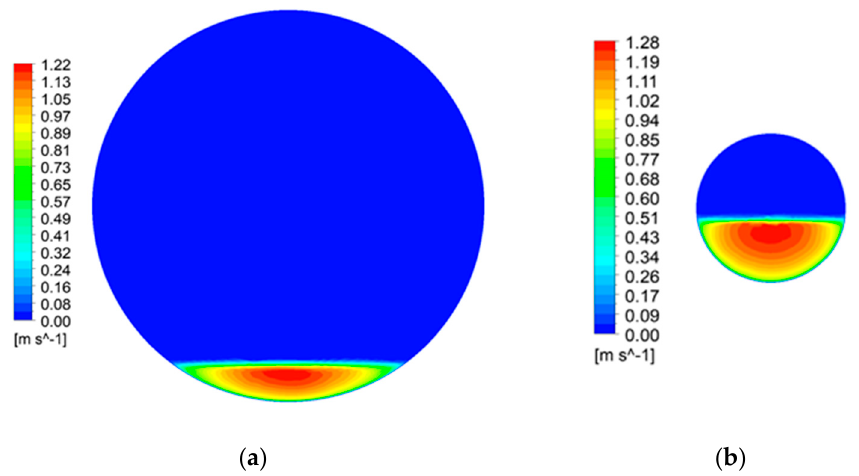
Figure 9. Velocity distribution in main pipe ( a ) and sub-pipe ( b ) by computation fluid dynamic modeling.